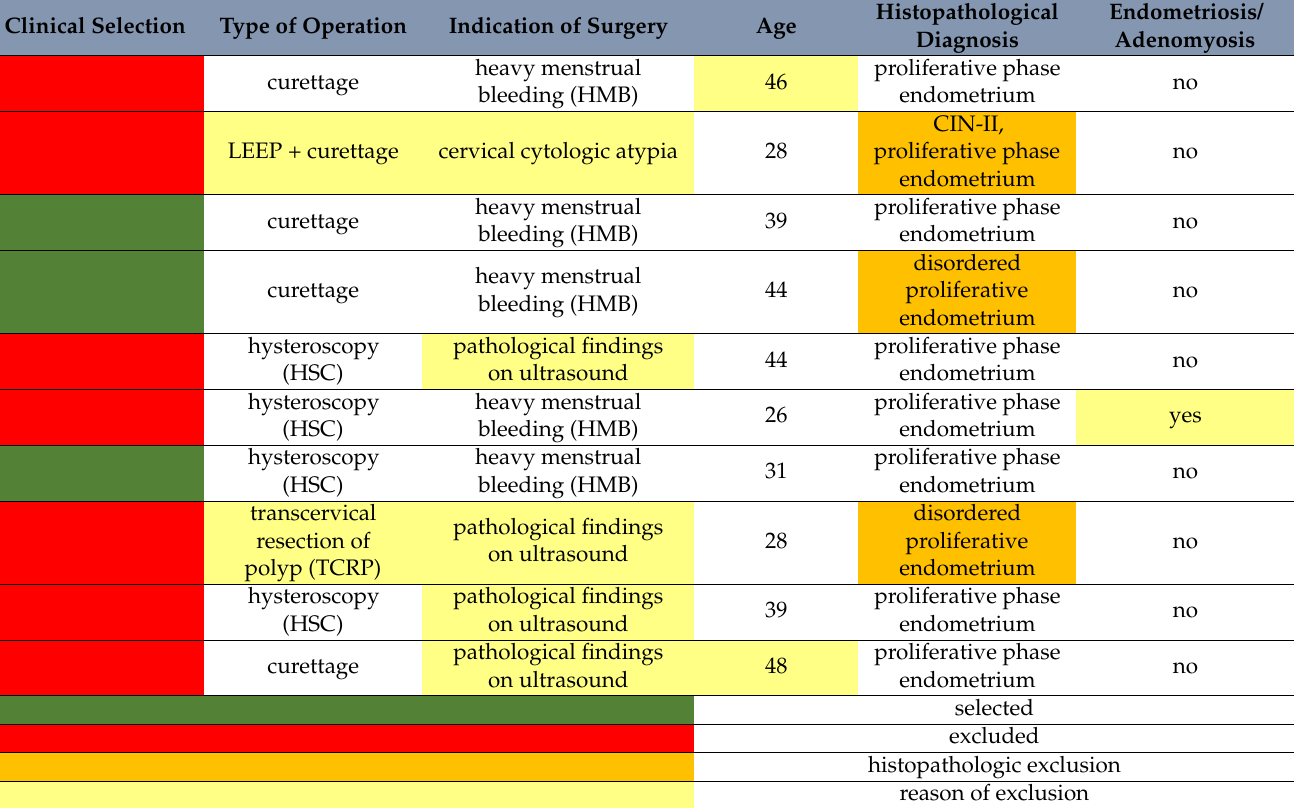
Table 2. Figure illustrating the applied selection and exclusion of cases with different